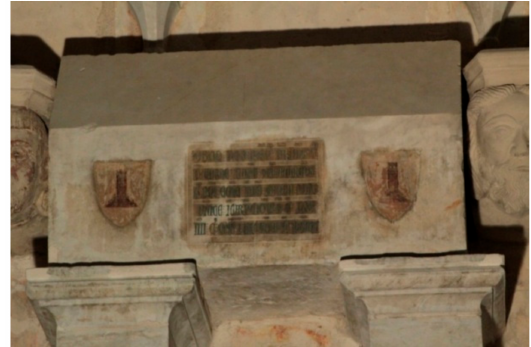
Figure 2. The burial urn of Bishop Guillermo de Torroja in Tarragona Cathedral.